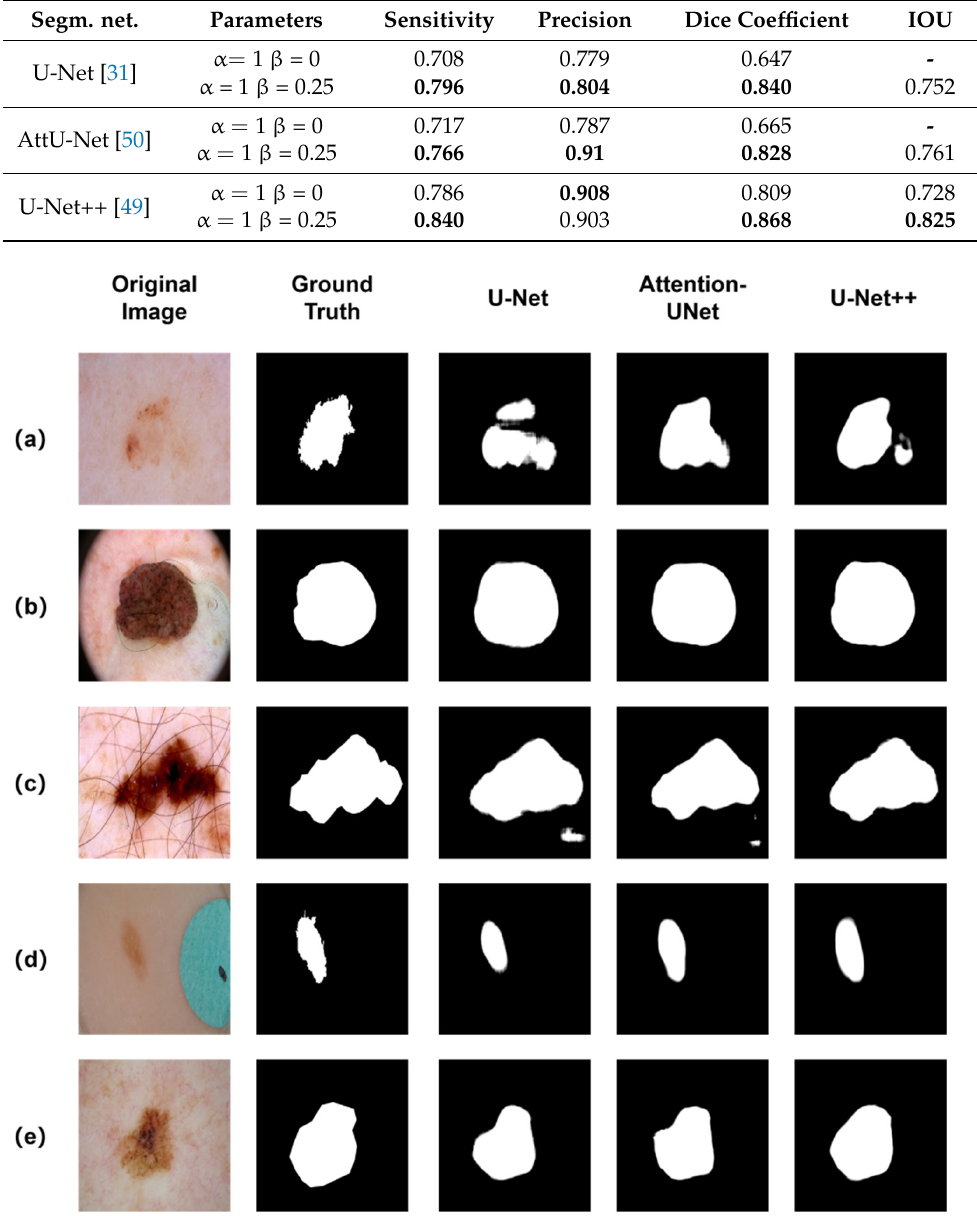
Figure 8. Visual comparison of lesion segmentation results produced by different segmentation network architecture with superpixel-oriented label distribution method. ( a ) low contrast; ( b ) black frame and bubbles; ( c ) hair artefact; ( d ) color illumination; ( e ) blood vessels.